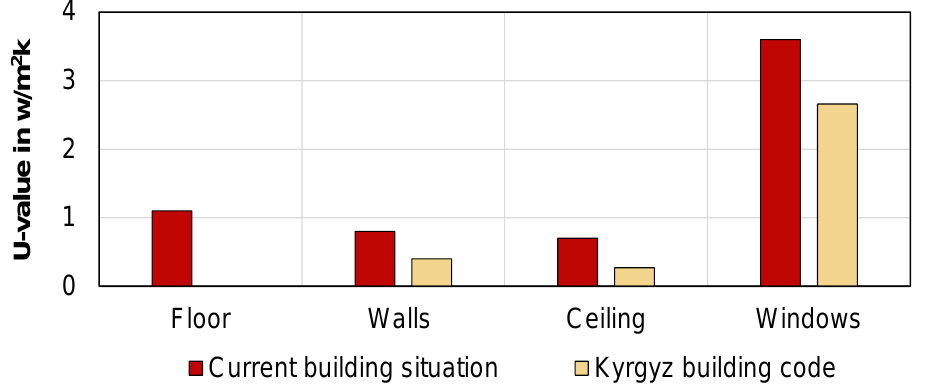
Figure 19. U-value of buildings based on the author’s observations (from the developed simulation model) vs. recommended U-values in Kyrgyz building code [33] .